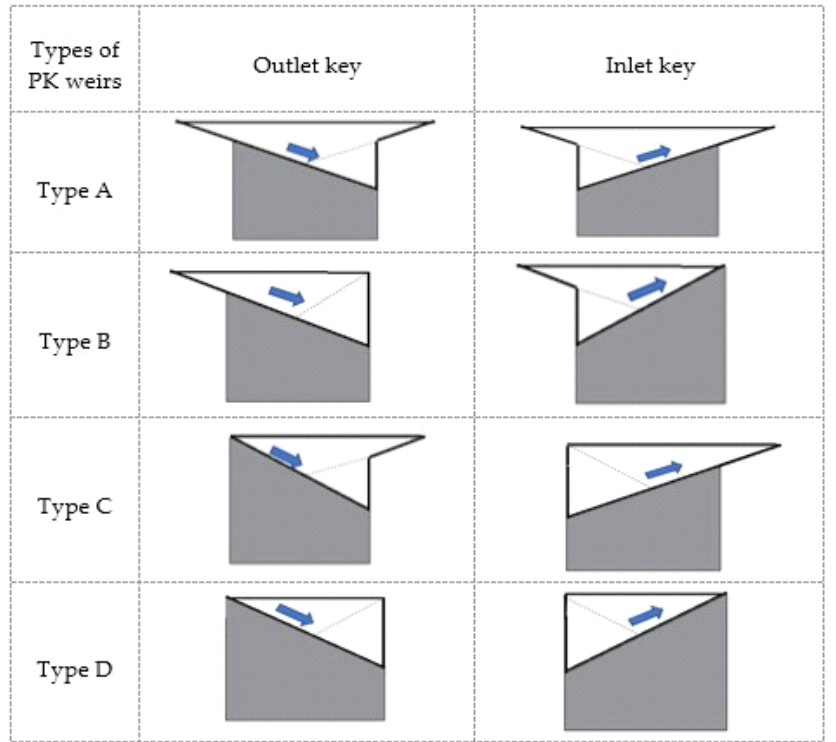
Figure 3. Types of PK weirs (A, B, C, and D).